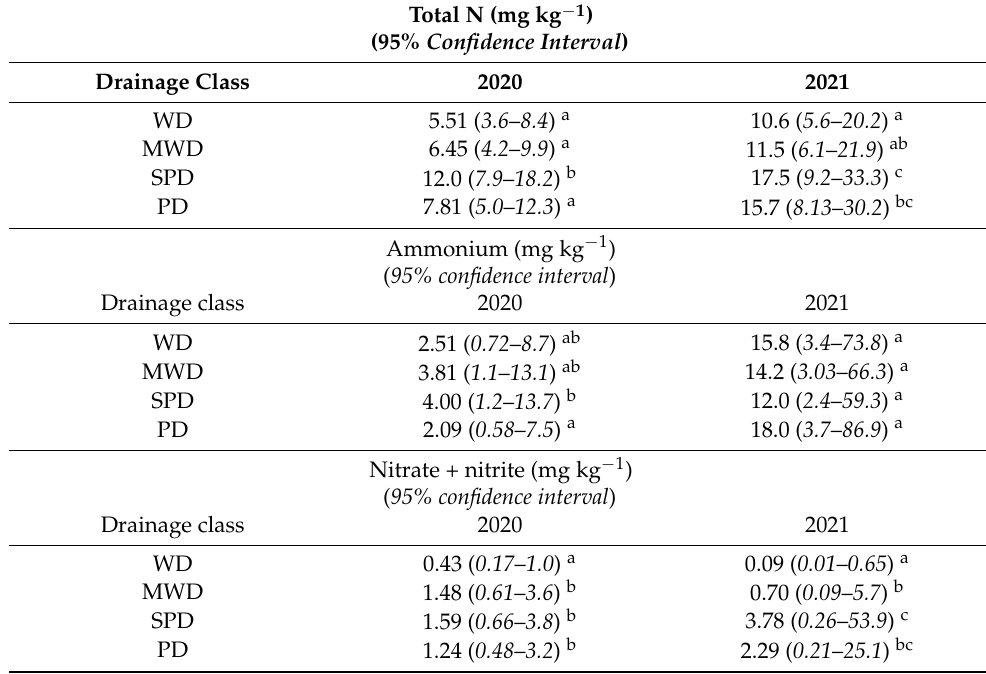
Table 2. The least square means of the concentrations of the extractable total N, ammonium, and NO 3 − + NO 2 − -N by drainage class during the growing seasons of 2020 and 2021. Groups with different superscript letters indicate significant differences ( p -value < 0.05) between drainage classes within a given